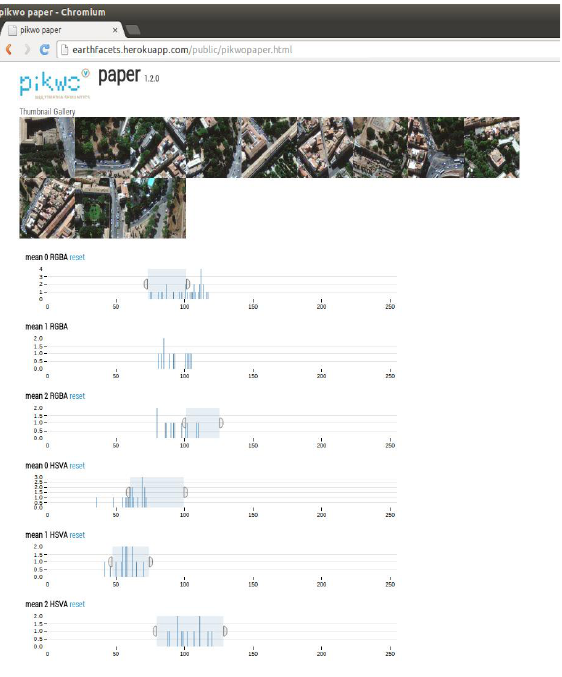
Figure 6: Search/Filtering results for class ”Trees”: Tree areas are identified by low luminosity areas with high saturation, provably because of the shadows that are visible in them. The selection of a specific Hue segment makes it unnecessary to use the Green component for filtering.